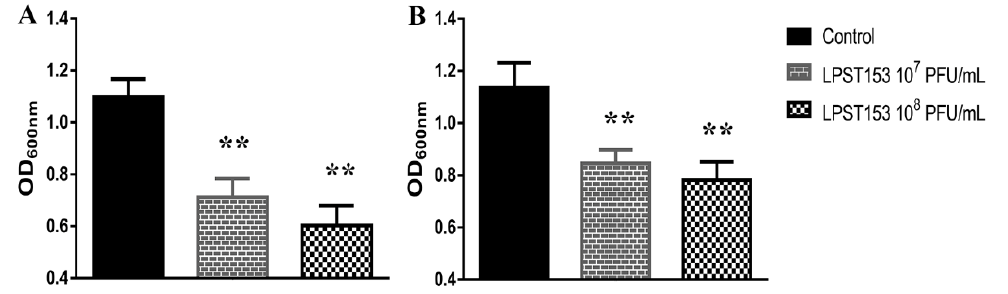
Figure 6. E ff ect of phage LPST153 on biofilm. ( A ) E ff ect of phage LPST153 on inhibition of biofilm in Figure 6. Effect of phage LPST153 on biofilm. ( A ) Effect of phage LPST153 on inhibition of biofilm in 96-well microplate at 30 ◦ C after 72-h incubation, and ( B ) E ff ect of phage LPST153 on 72-h-old biofilm 96-well microplate at 30 °C after 72-h incubation, and ( B ) Effect of phage LPST153 on 72-h-old biofilm in 96-well microplate at 30 ◦ C after 12 h postinfection. Values represent mean with standard deviation in 96-well microplate at 30 °C after 12 h postinfection. Values represent mean with standard deviation of six determinations. ** Significant at p < of six determinations. ** Significant at p < 0.01.